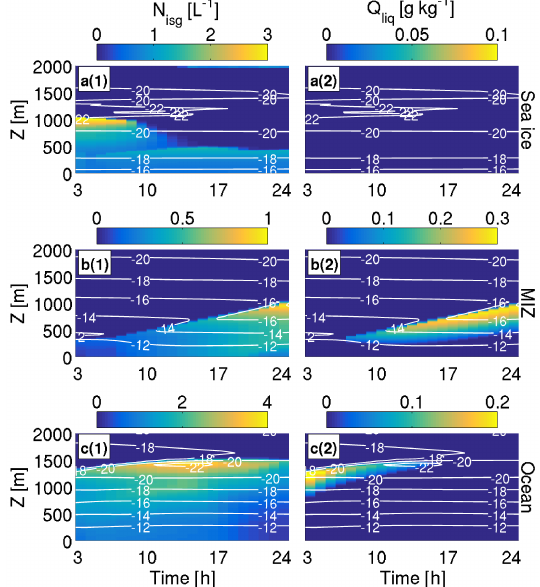
Figure 5. Simulated ice number concentrations ( N isg , a1–c1 ) and liquid water mixing ratios ( Q liq , a2–c2 ) using the C86 parameter- isation under default WRF conditions ( T < − 8 ◦ C, S w > 0.999, or S i > 1.08). (a) Sea ice (case 1), (b) MIZ (case 2), (c) Ocean (case 3). Run length 24h. Temperature ( ◦ C) contours are overlaid in white. Note changing colour bar for each subfigure.